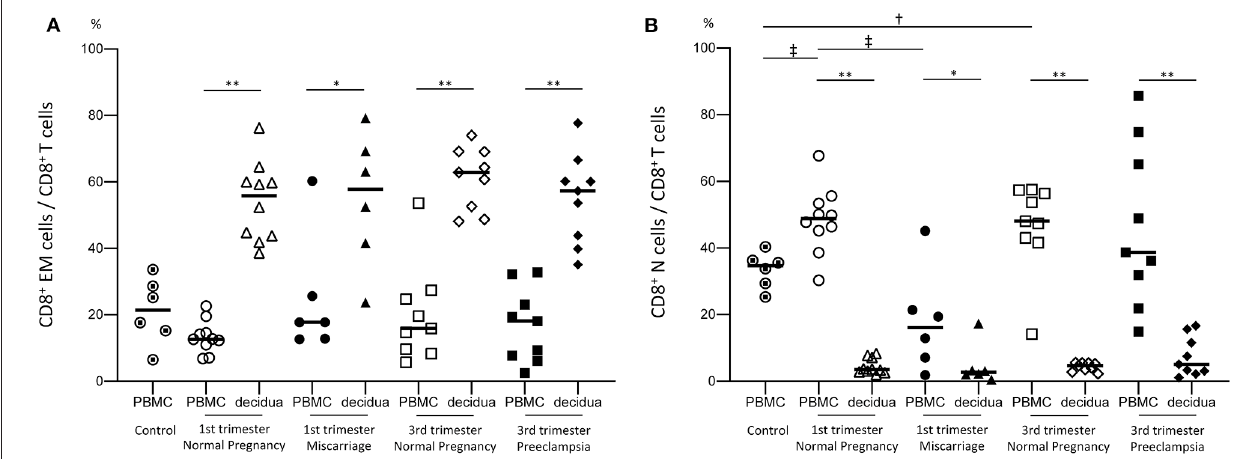
FIGURE 1 | Proportion of CD8 + EM and CD8 + N cells among total CD8 + T cells. The proportion of CD8 + EM cells among CD8 + T cells (A) and that of CD8 + N cells among CD8 + T cells (B) are shown. Statistical analysis was performed using Wilcoxon matched-pairs single rank test (PBMC vs. decidua in each group); * p < 0.05; ** p < 0.01. Mann-Whitney U -test (control vs. 1st or 3rd trimester normal pregnancy, 1st vs. 3rd trimester normal pregnancy, 1st trimester normal pregnancy vs. miscarriage, 3rd trimester normal pregnancy vs. preeclampsia); † p < 0.05; ‡ p <